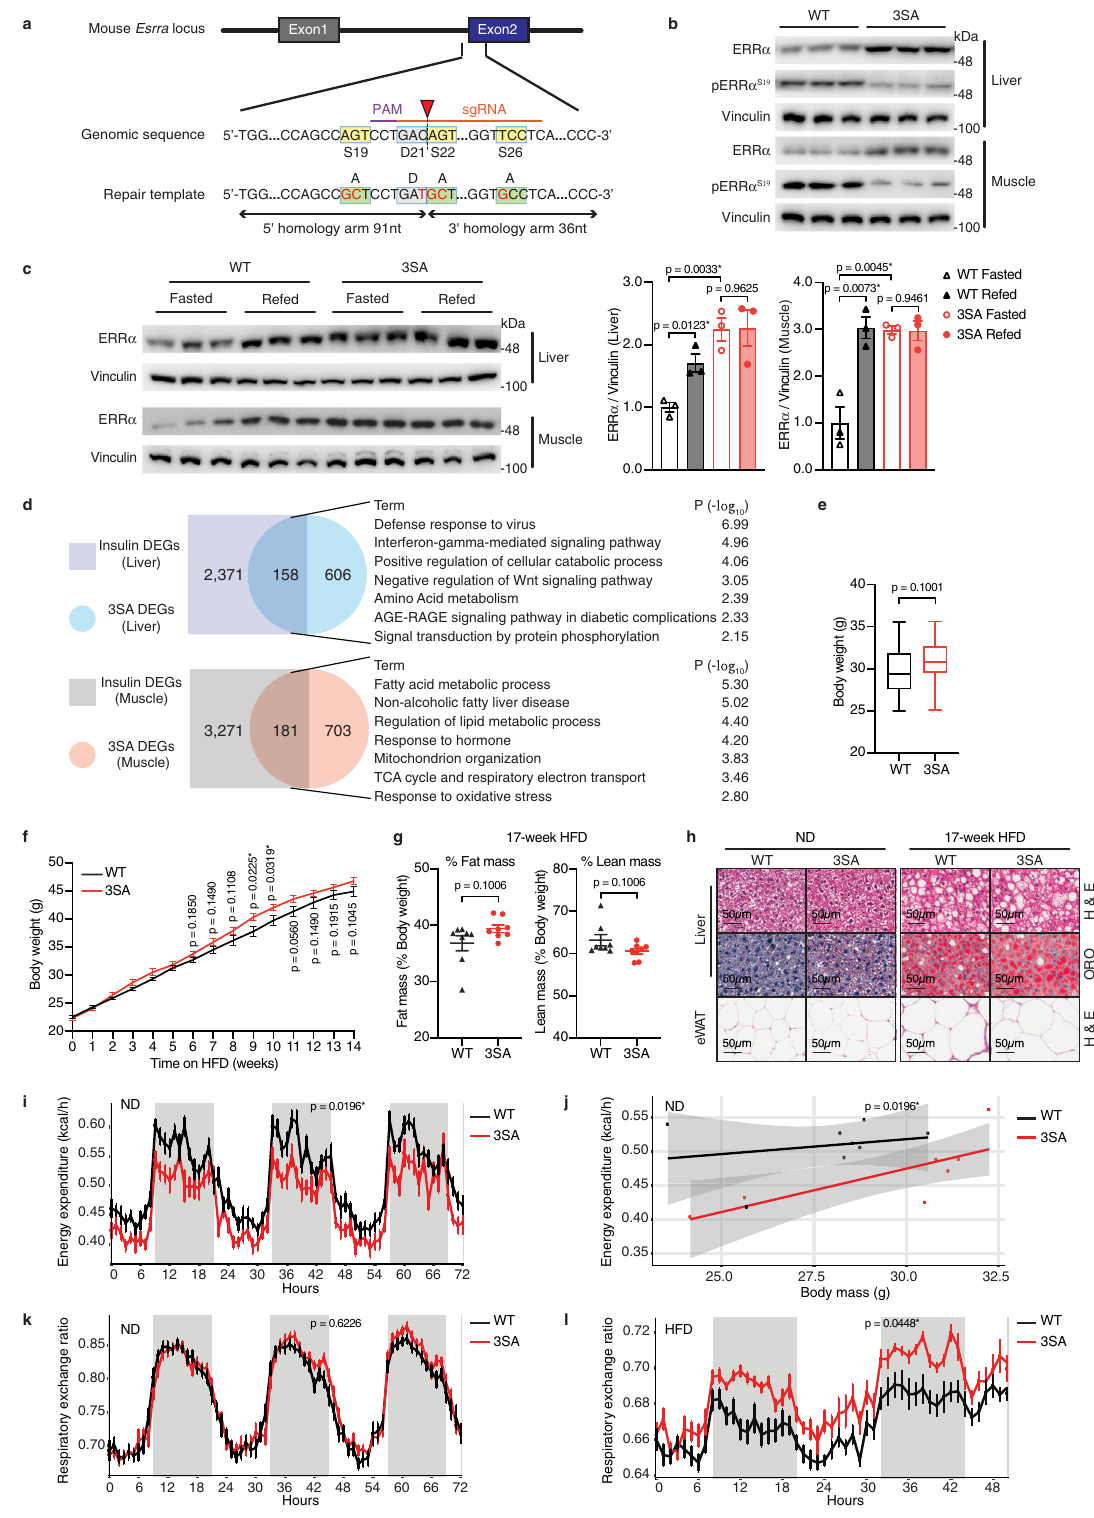
metabolites have been shown to interfere with insulin signaling major skeletal muscle lipid transporter fatty acid-binding protein and provoke insulin resistance 38 . Thus, FA oversupply to 3 ( Fabp3 ), and lipoprotein lipase ( Lpl ) (Fig. 6o), a rate-limiting ERR α 3SA skeletal muscle, especially upon a HFD, might further enzyme activated by insulin to stimulate TG hydrolysis and peripheral fatty acid (FA) uptake. Consistently, ERR α 3SA mice diminish glucose disposal in muscle, resulting in increased showed increased postprandial muscle FFAs (Fig. 6p), likely a glucose diversion to liver. Indeed, HFD-fed ERR α 3SA mice compensation for impaired insulin-stimulated glucose uptake. displayed increased hepatic glucose metabolism, re fl ected by Intramyocellular accumulation of saturated FFAs, lipid and lipid elevated expression of genes encoding glucokinase ( Gck ) and NATURE COMMUNICATIONS| (2022) 13:2105